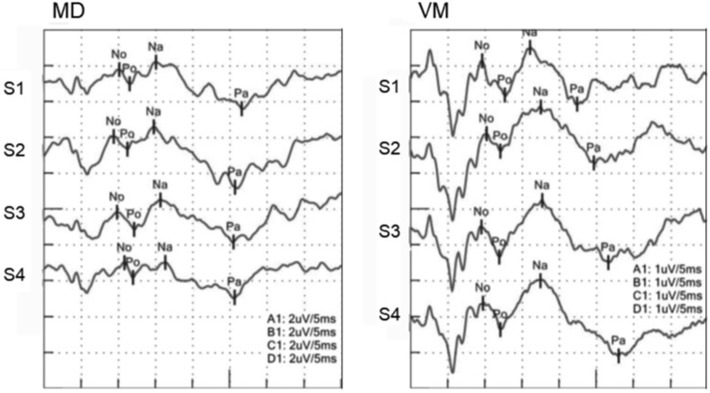
AMLRs to repetitive stimuli. (Left) AMLR of an MD patient. (Right) AMLR of a VM patient. Although an MD patient showed decreasing Na-Pa amplitudes to repetitive stimuli, a VM patient showed increasing Na-Pa amplitudes to repetitive stimuli.